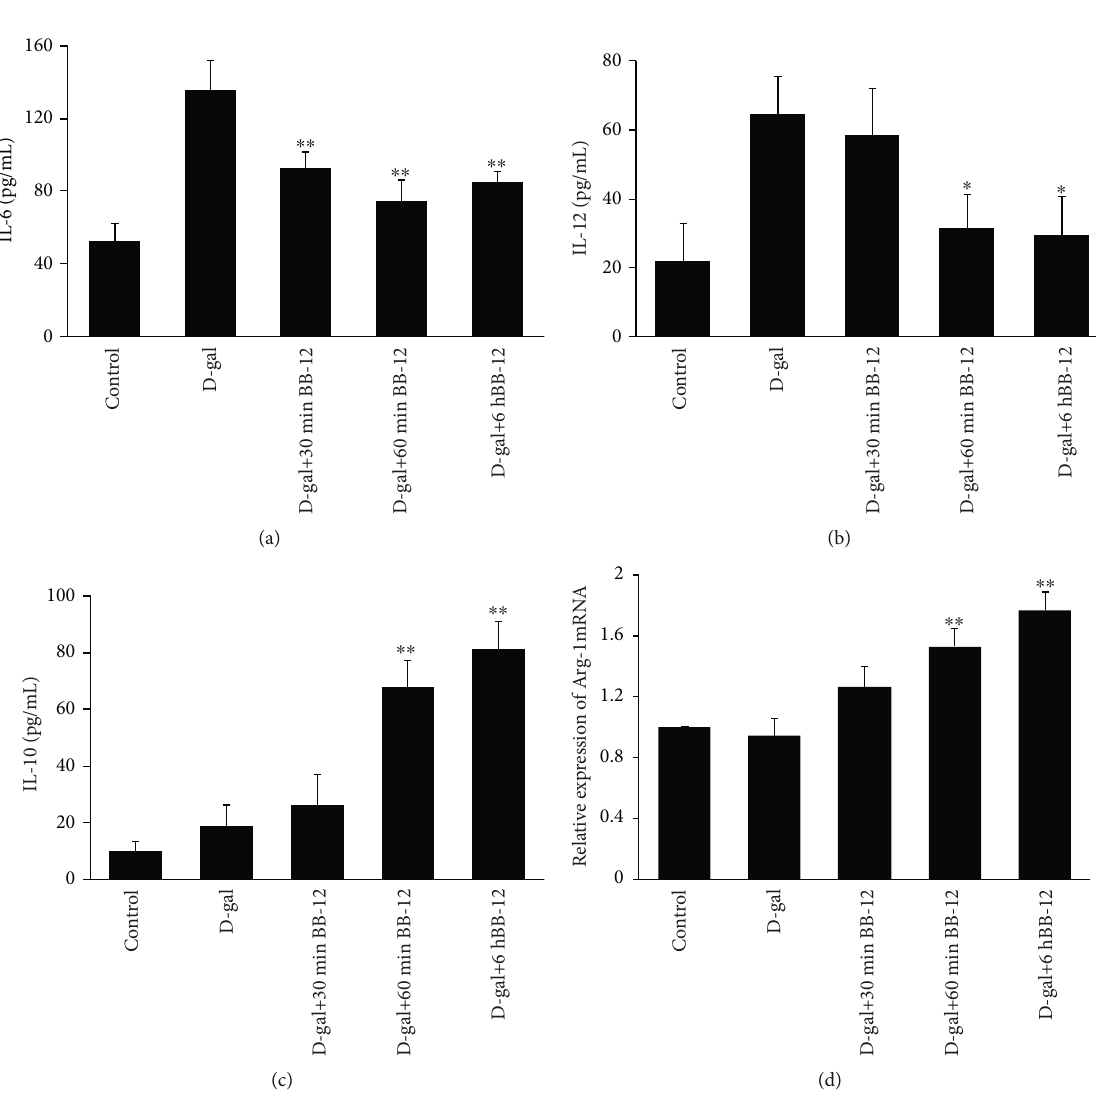
Figure 6: E ff ects of BB-12 on J774A.1 macrophage polarization. The production of IL-6 (a), IL-12 (b), and IL-10 (c) was assayed by ELISA. The results showed that the IL-6 and IL-12 levels in the D-gal+60min and D-gal+6h groups decreased compared with that in the D-gal group ( ∗ P < 0 : 05 or ∗∗ P < 0 : 01 , n = 3 ). IL-10 in the D-gal+60min and D-gal+6h groups was signi fi cantly higher than that in the D-gal group ( ∗∗ P < 0 : 01 , n = 3 ). (d) qPCR analysis of the relative expression level of Arg-1 mRNA. GAPDH was used as an internal control. The Arg-1 mRNA expression level in D-gal+60min and D-gal+6h groups increased compared with that in the D-gal group ( ∗∗ P < 0 : 01 , n = 3